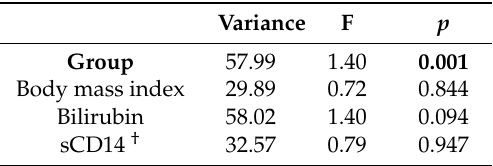
Table 4. Shown are possible explanatory variables for di ff erences in microbiome composition of SC-CIP and CIP controls, but all three variables dropped out in the multivariate analysis with RDA + and only group assignment remained. Significant confounders are marked in bold. In column one, the variance is shown, in column two, results of the F-test are shown and in column 3, the p -value is indicated